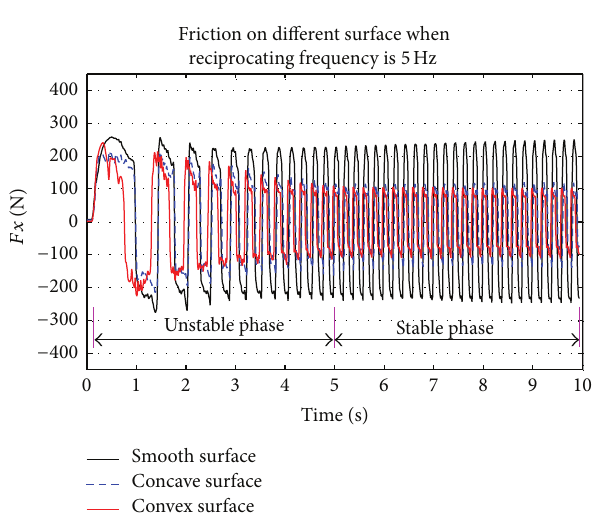
Figure 8: Friction force between rape stalk and three different metal plates at reciprocating frequency of 5 Hz.